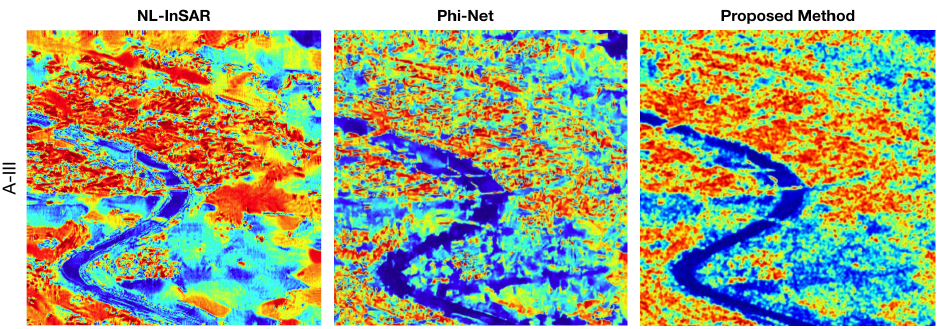
Figure 21. Coherence images of the considered site A-III estimated using all the compared